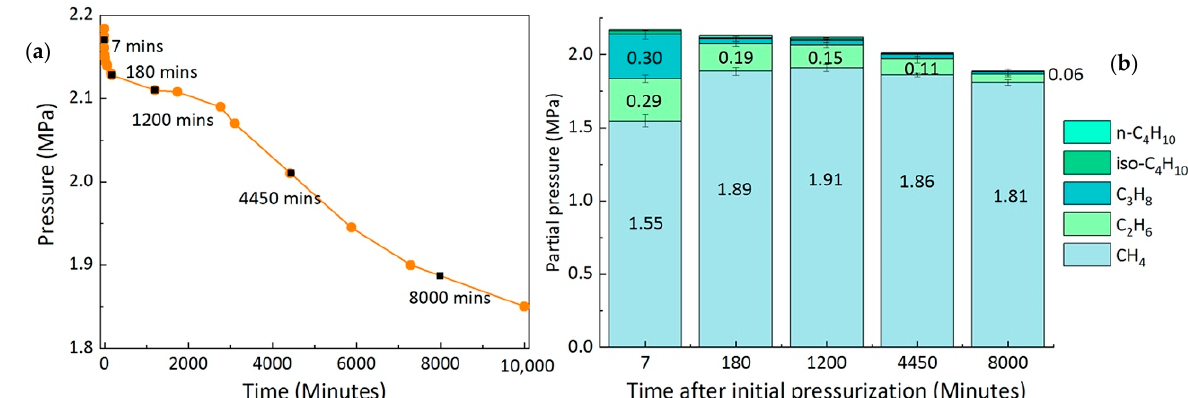
Figure 3. Changes in the absolute pressure of the sample cell ( a ) and the partial pressure changes of each component measured at different times in the closed system ( b ). The black squares in Figure 3a indicate the specific measuring time during the ongoing experiments.